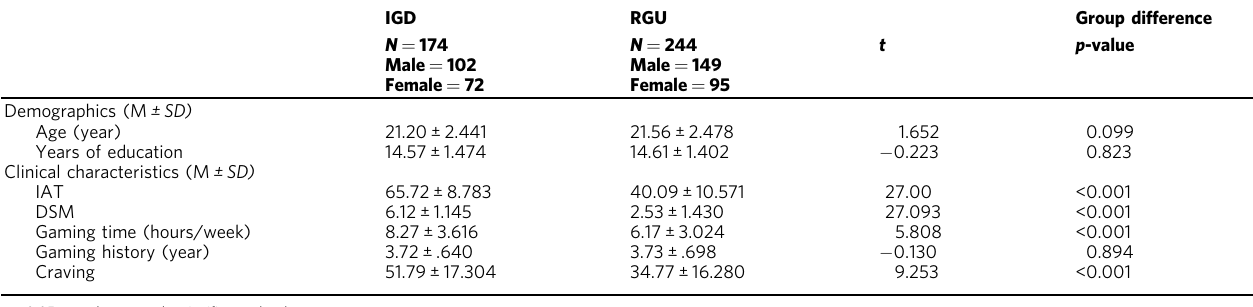
Table 2 Demographics and clinical characteristics of all